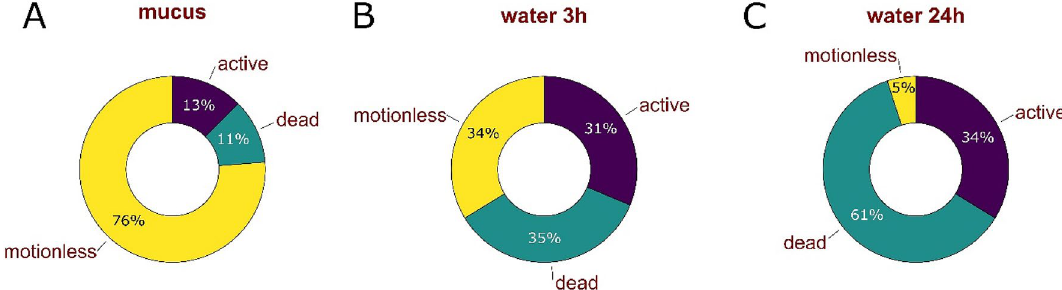
Figure 5. Percentage of active, dead and motionless tardigrade individuals: ( A ) 30 min after contact with snail mucus, ( B ) tuns covered with dried mucus 3 h following rehydration, ( C ) tuns covered with dried mucus 24